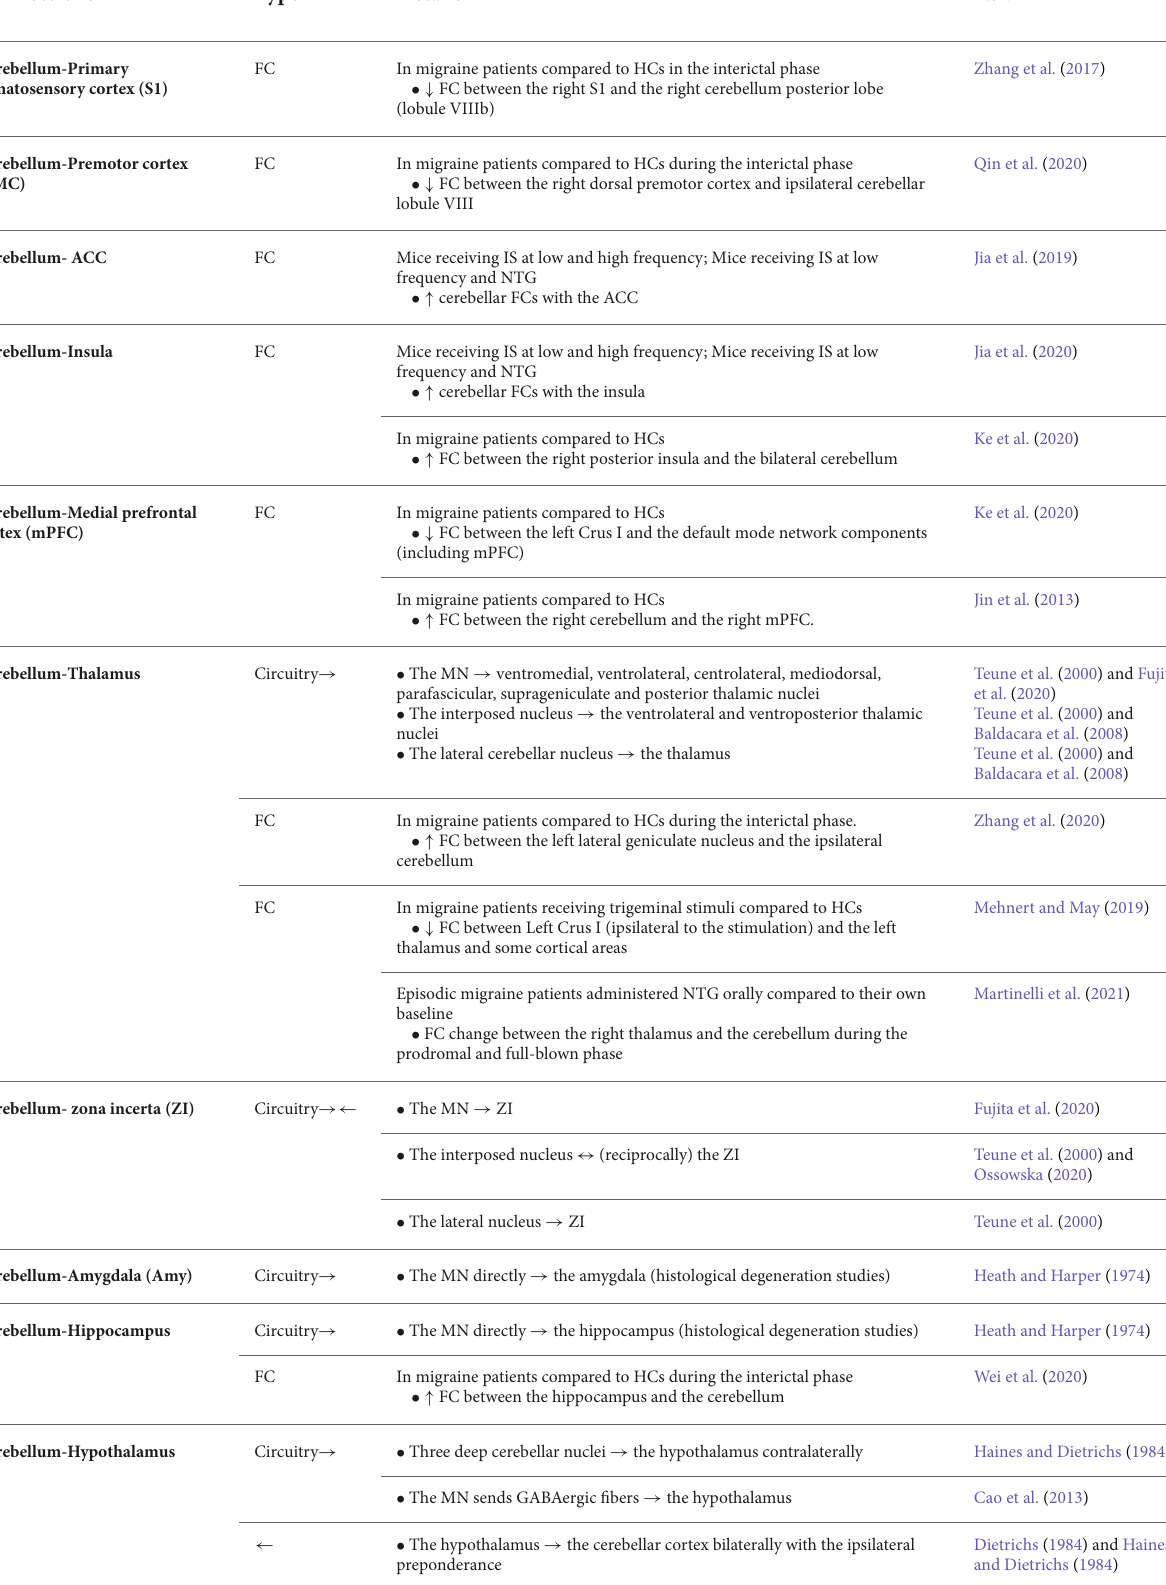
TABLE 1 Cerebellar connections with pain or migraine-relevant brain regions.